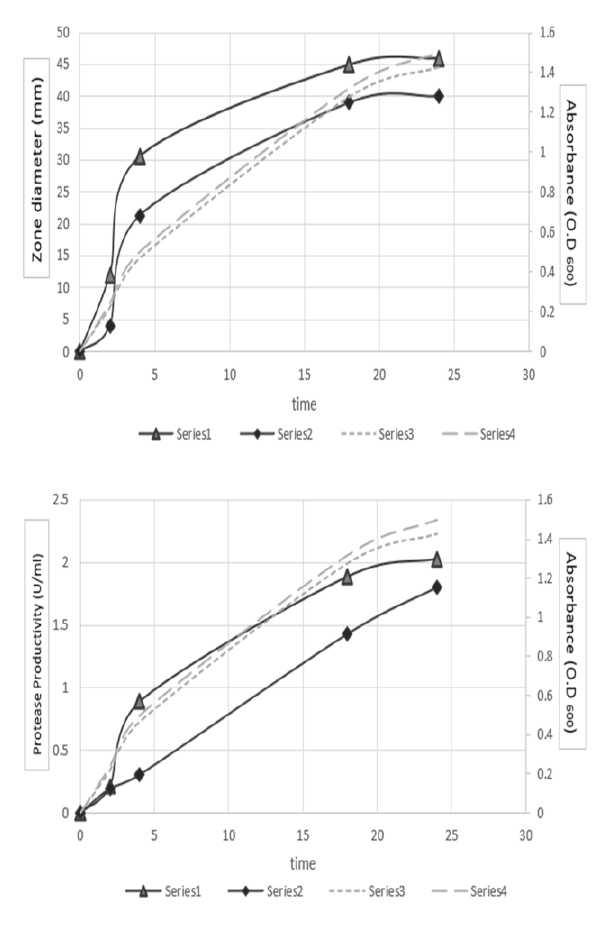
Fig. 1. Effect of synthetic signal on (A) rhamnolipid and (B) protease production of P. aeruginosa where series 1 represents production in induced test culture, series 2 represents production in control culture, series 3 represents growth curve for test culture expressed in terms of